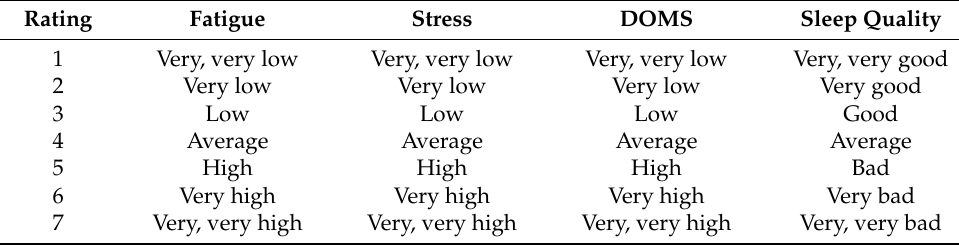
Very, very high Very, very bad DOMS: delayed onset muscle